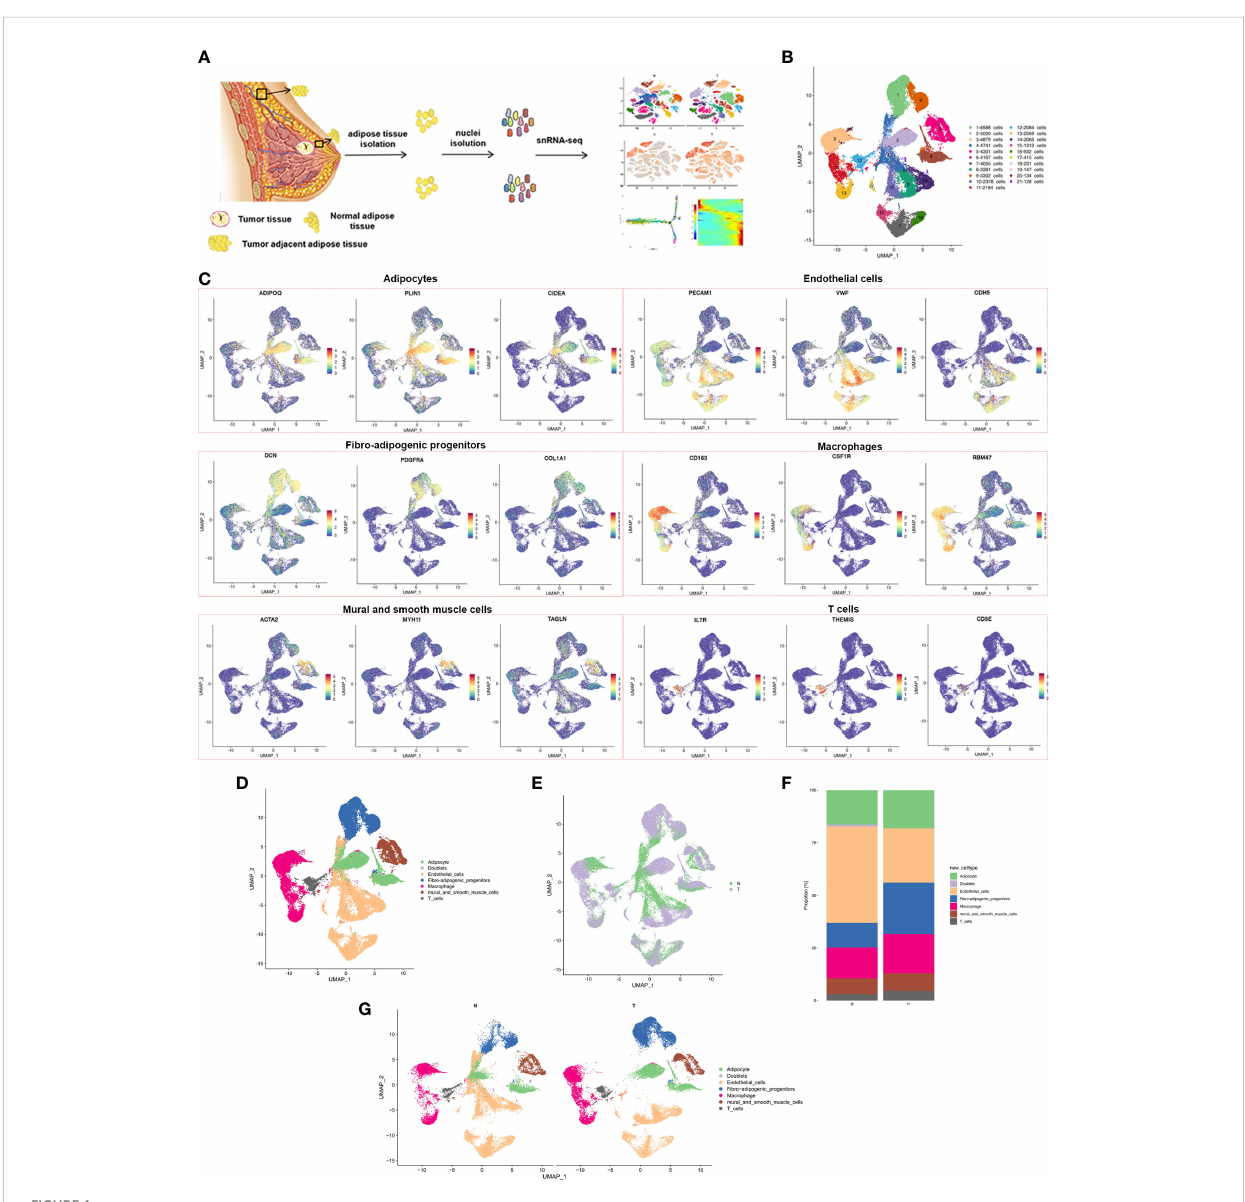
FIGURE 1 snRNA-seq of breast cancer adipose tissues. (A) Overview of the study work fl ow showing the collection and processing of samples from three patients for scRNA-seq (B) UMAP plot of 21 clusters of all cells from the 6 samples pro fi led in this study, with each cell color coded to indicate the associated subclusters and cell numbers. (C) Expression of cell-type-speci fi c marker genes illustrated in UMAP plots. Canonical cell markers were used to label clusters by cell identity as represented in the UMAP plot. Cell types were classi fi ed as adipocytes, endothelial cells, fi bro-adipogenic progenitors, macrophages, mural and smooth muscle cells or T cells as indicated in the legend. (D) UMAP plot of all cell types across 6 samples pro fi led in this study, with each cell color coded to indicate the associated cell types (E) Cells on the UMAP plot of all 6 samples were colored as originating either from N or T group. (F) UMAP plot of all cell types annotated in each group, with each cell color coded to indicate the associated cell types. (G) The relative ratio of all cell types in N and T group shown using bar plots, with each cell color coded to indicate the associated